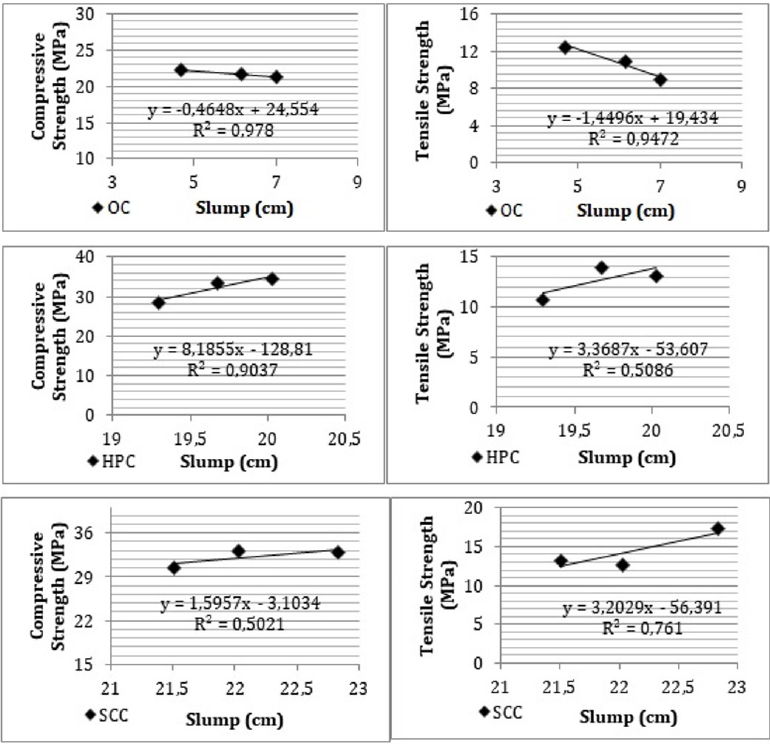
Figure 7. Correlation among slump and mechanical strength in OC, HPC and SCC.